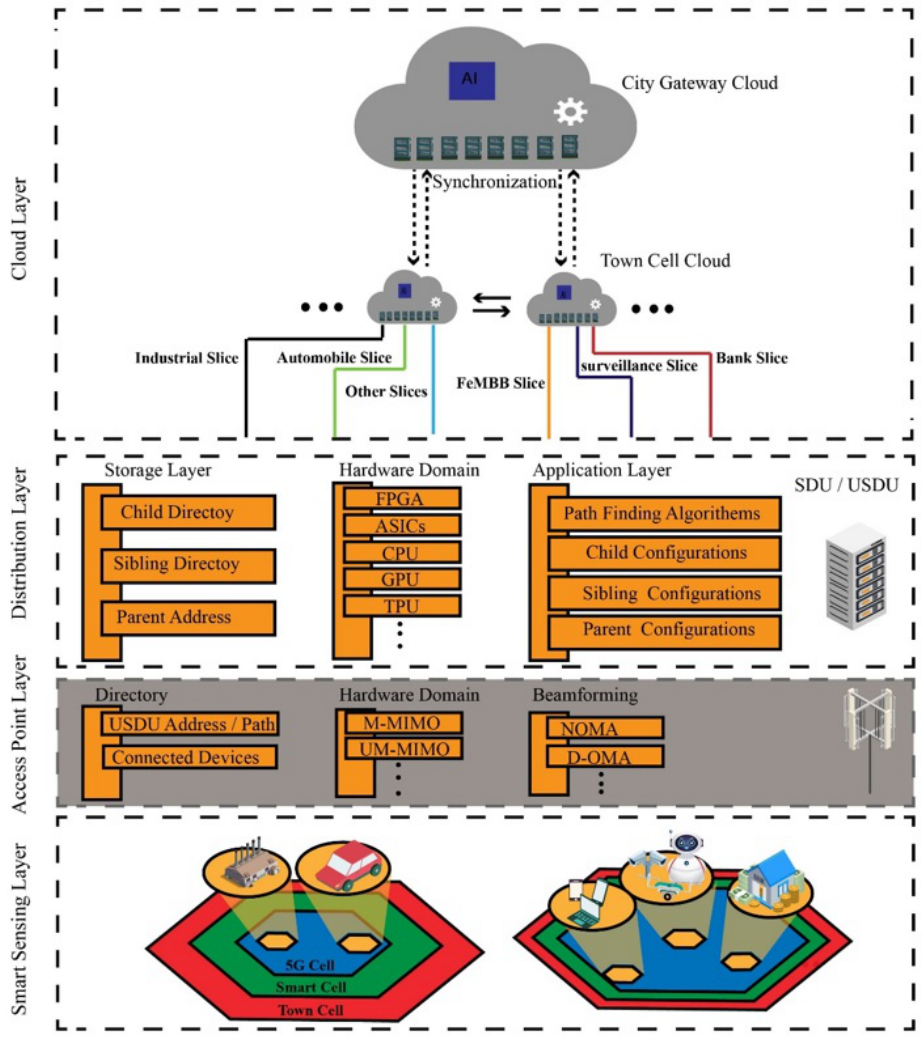
Figure 3. Logical layers in Bee Hive